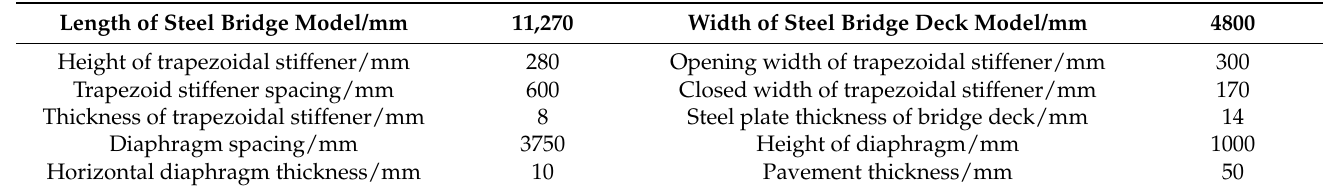
Table 11. The geometric dimensions of each component in the steel bridge deck pavement model.